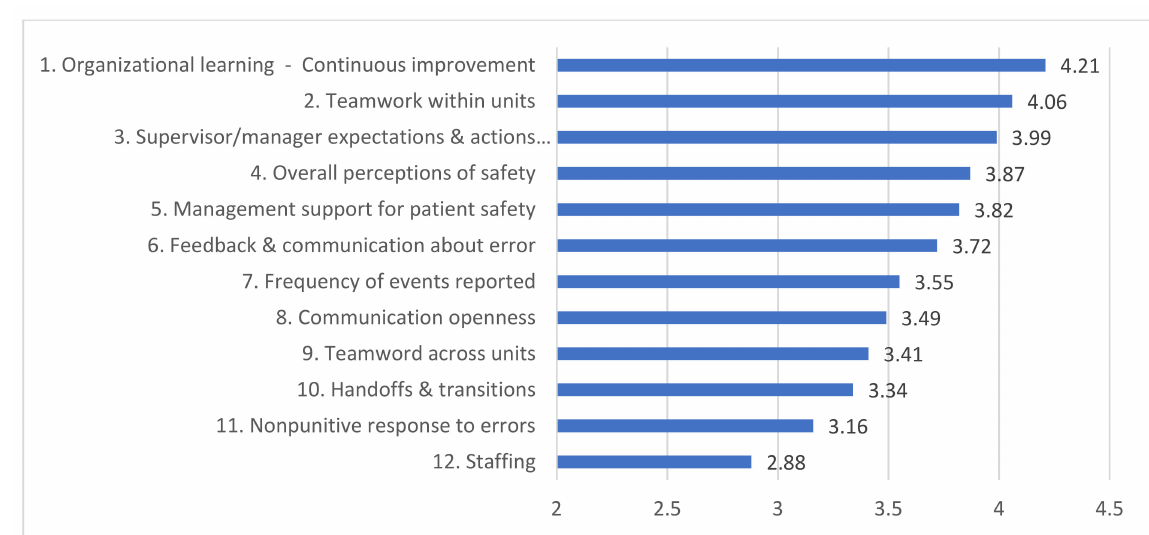
Figure 1. Figure shows ranking of the 12 dimensions of interest based on the data from the current study performed in Romania. For seven dimensions, there were significant differences between tertiary and sec- ondary hospitals and higher scores were reached by secondary hospitals. Employees in AICDs of secondary hospitals perceived “Teamwork within units” (4.36 ± 0.51) much better than those in tertiary hospitals (3.96 ±